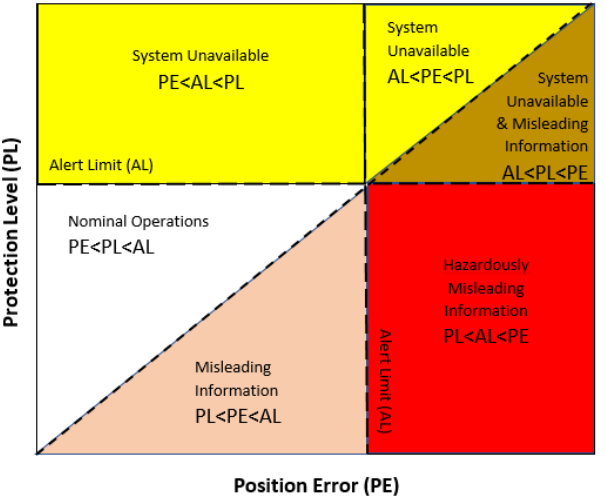
Figure 2. Stanford diagram distribution for EGNOS (Own figure based on [44]).